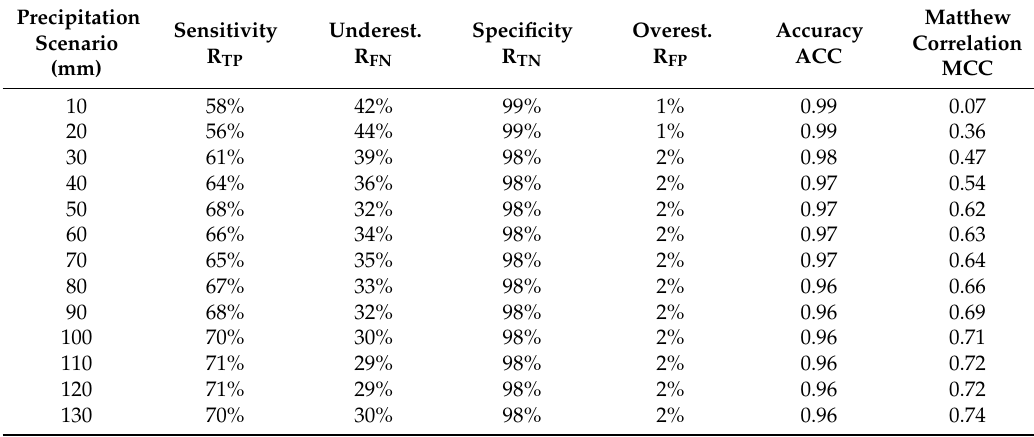
Table 1. Safer_RAIN performances obtained by comparing the obtained flood hazard maps with the benchmarking maps (2D-hydrologic-hydrodynamic maps) for several rainfall